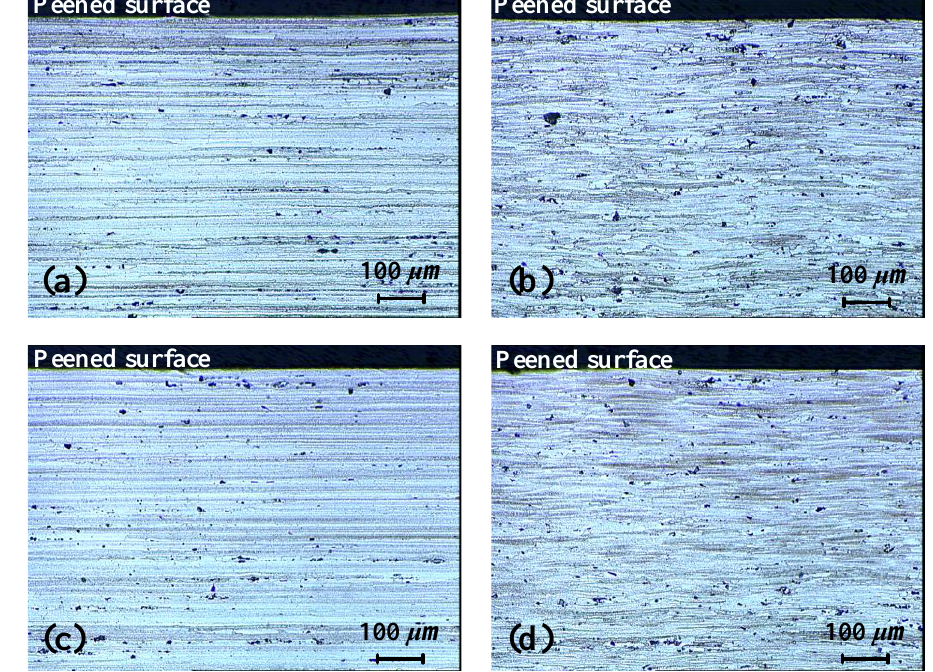
Figure 6. Cross-sectional microstructure of the 3- and 9-mm LPF sheets: ( a ) 3-mm sheet in the rolling direction (RD), ( b ) 3-mm sheet in the transverse direction (TD), ( c ) 9-mm sheet in the RD, and ( d ) 9-mm sheet in the TD.